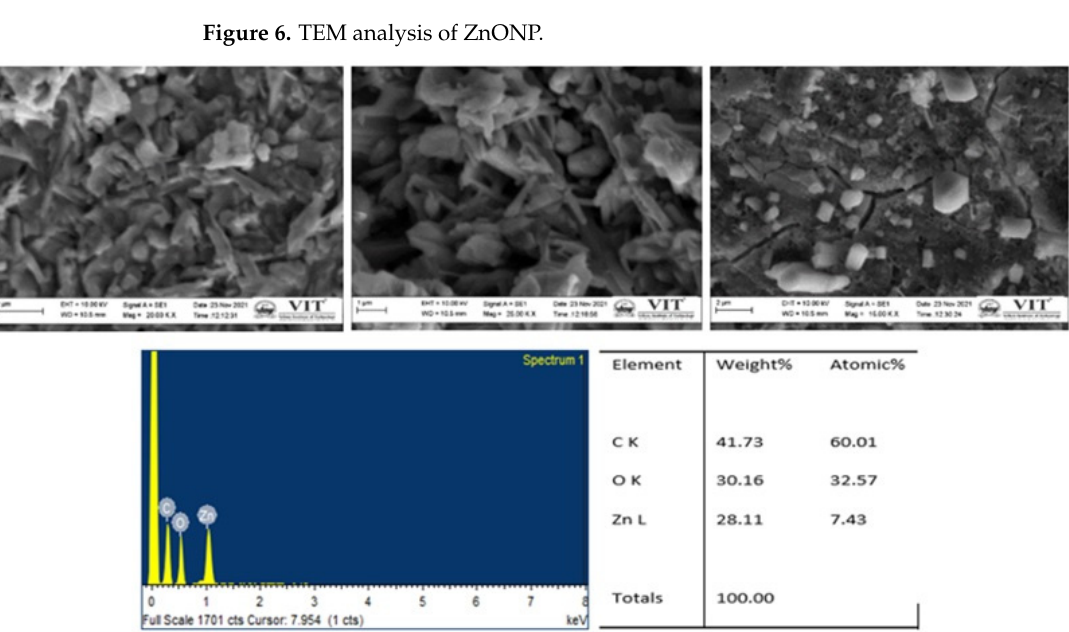
Figure 7. SEM and EDX analysis of ZnONP.